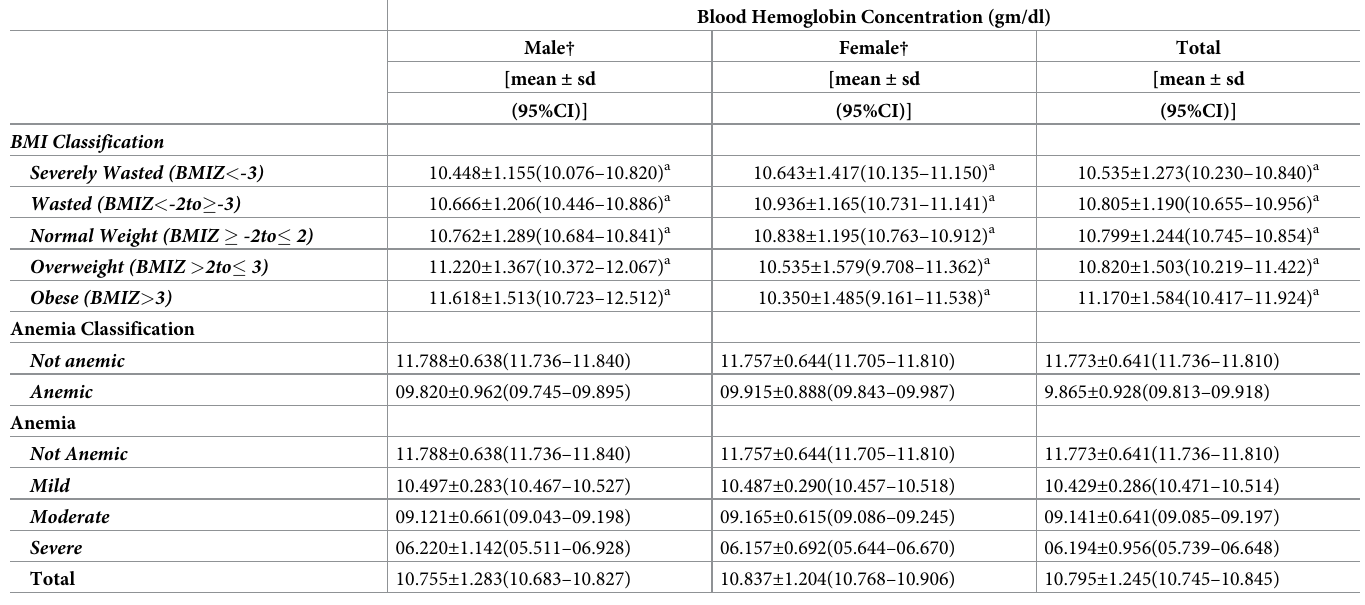
Table 4. Blood hemoglobin level of children (n = 2373) based on BMI SD score and gender category.